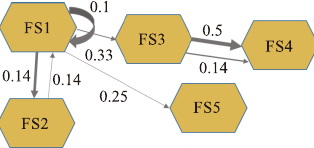
Fig. 4 An example of base disease progression network. Each node represents a different frequent disease-process subgraph. The weight of the edge indicates the probability of two nodes occurring in consecutive time, and the thickness of the edge is the time span after which the later node occurs after the previous